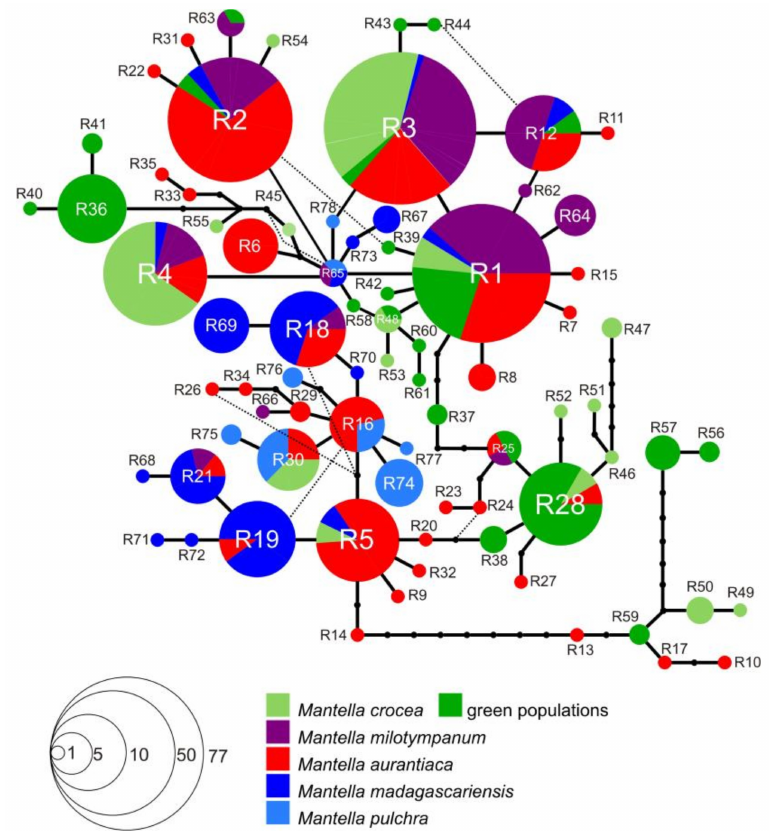
Figure 4. Haplotype network of 78 unique haplotypes of Mantella crocea , M. milotympanum , M. aurantica , M. madagascariensis and M. pulchra (color code as in Figures 1 and 3), based on the analysis of a 732-bp fragment of the RAG-1 gene. Size of circles is proportional to the number of individuals sharing a given haplotype. Shared haplotypes are indicated by circles, with the area being proportional to the number of individuals sharing that haplotype (haplotype frequencies as in the inset legend). Inferred intermediate haplotypes are indicated by small black